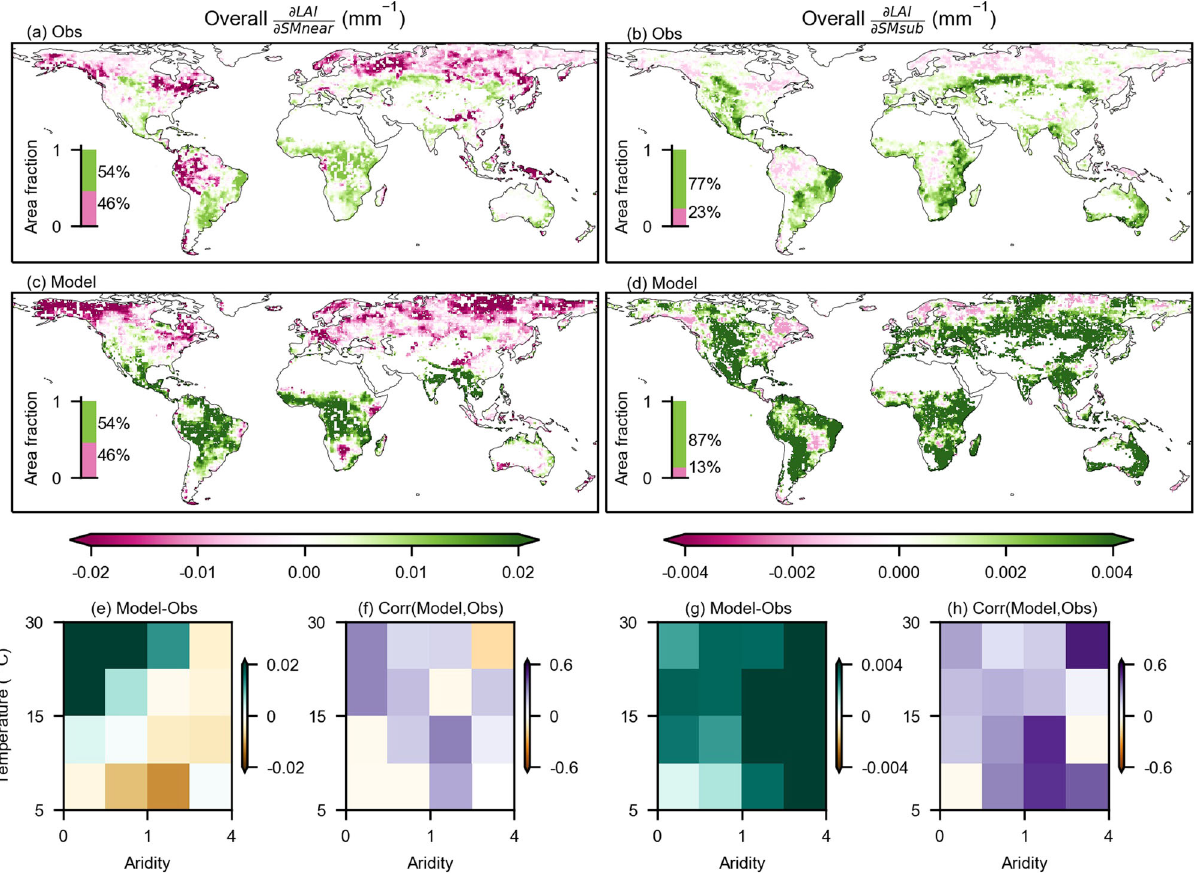
Fig. 1 Global sensitivity of LAI to soil moisture in the period 1982-2017. a , b LAI sensitivity to near-surface ( ∂ LAI ∂ SMnear ) and to sub-surface soil moisture ( ∂ LAI ∂ SMsub ) from observations (Obs), given as respective ensemble means (Methods: Overall sensitivity). c , d Similar to a , b but for land surface models (Model). e , g Mean differences between observational and model results across climate regimes. f , h Spatial coherence between observational and model results inferred by correlation coef fi cients using sub-regional data across climate regimes. All panels apply the two-sided signi fi cance test at the p < 0.01 level as assessed with Theil-sen regressions for each grid cell, and grid cells which pass the signi fi cance test are colored according to the sensitivity values in a – d . To note that the results are a descriptive measure, as the fi eld signi fi cance is not